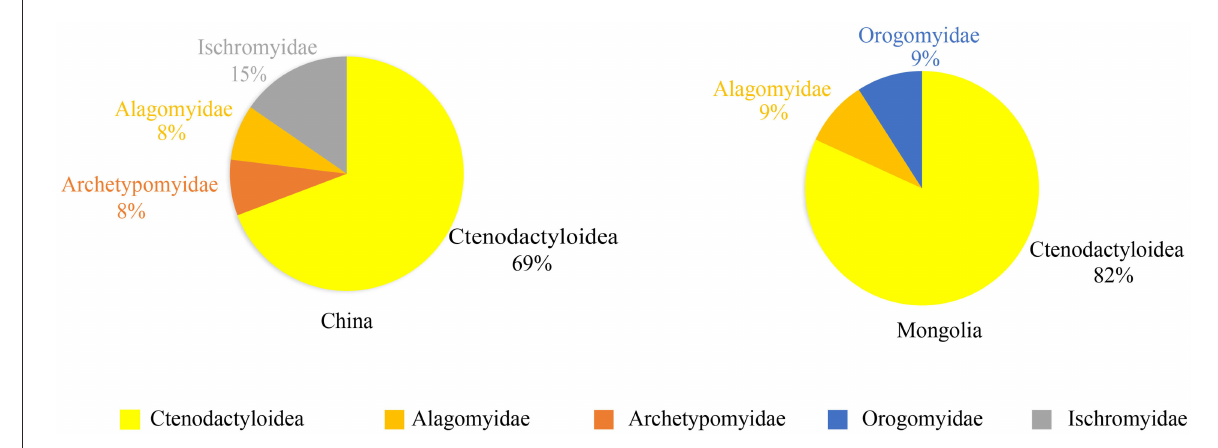
FIGURE2 Diagrams of the Bumbanian rodent composition from China and Mongolia in East Asia (in percentage of genera).